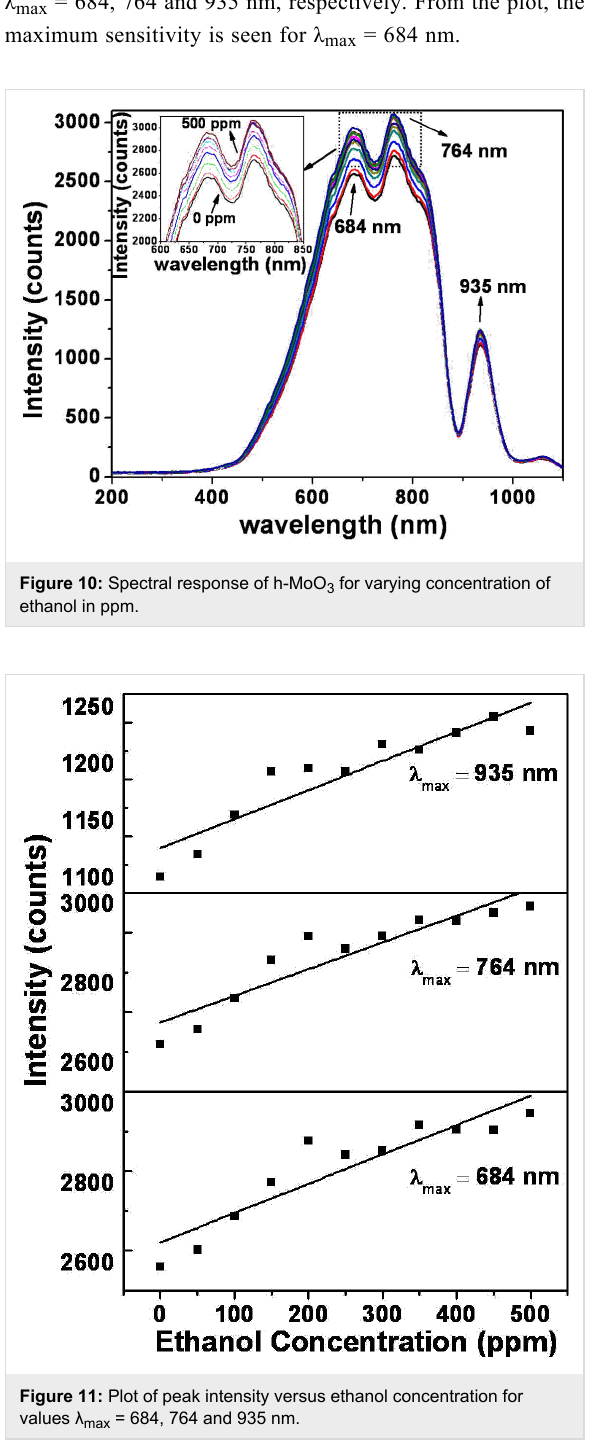
Here, it is proposed that the gas sensing mechanism follows the changes in the refractive index and evanescent wave